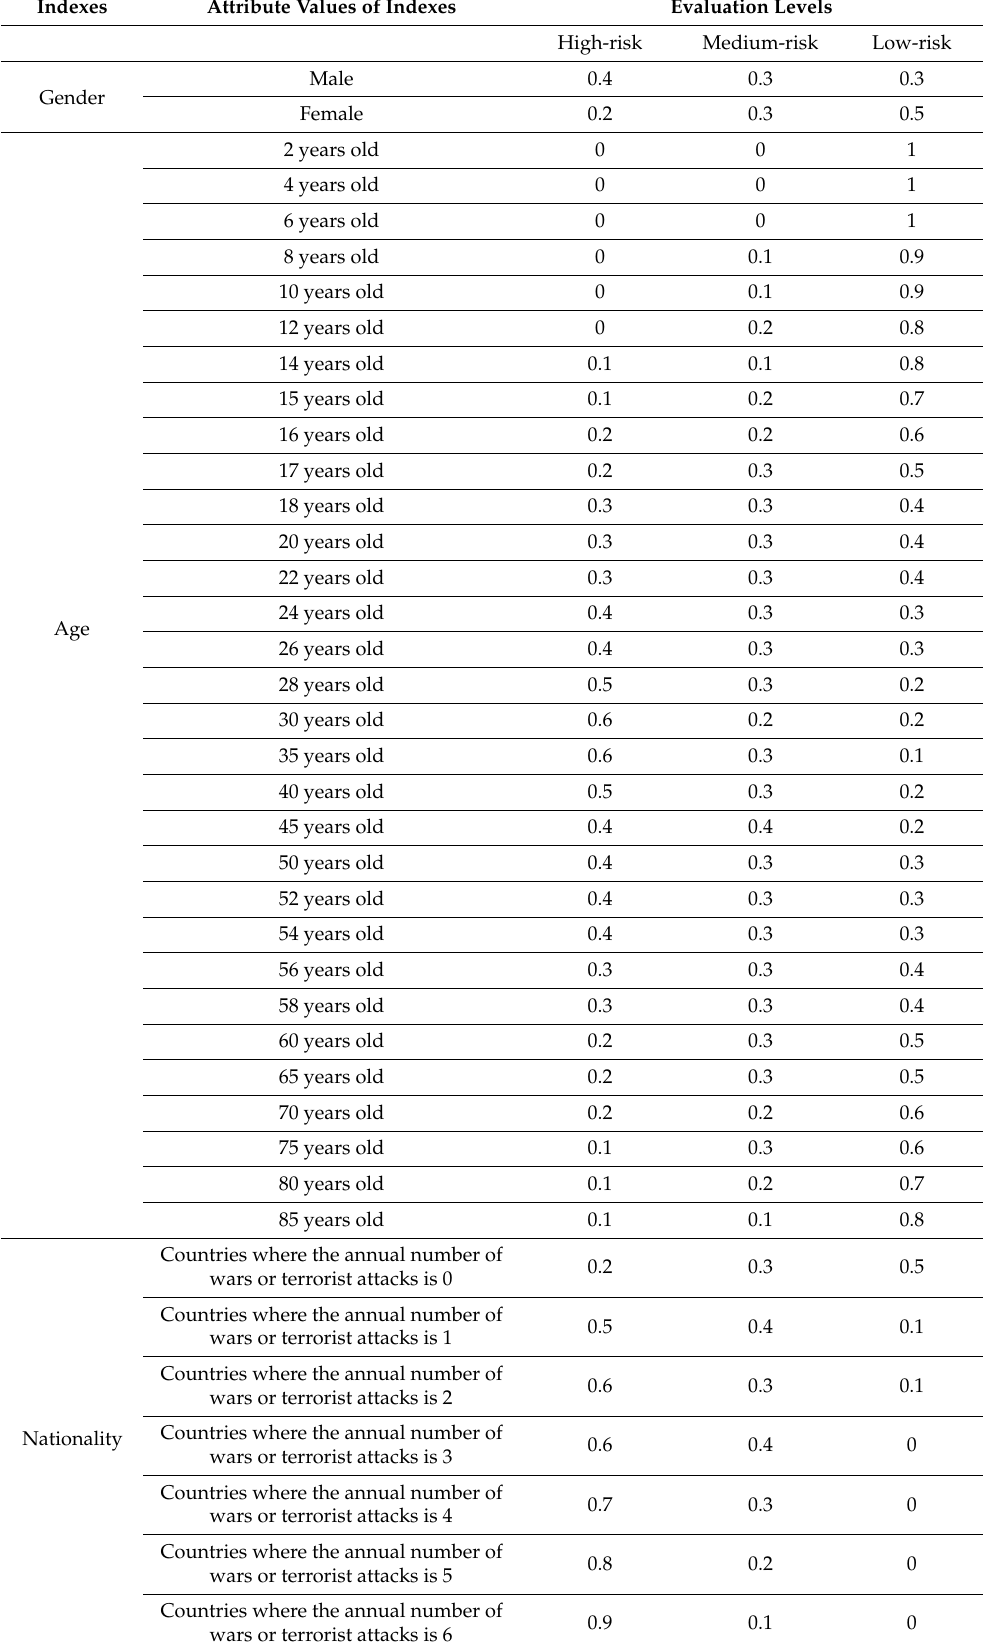
Table A12. Single factor evaluation of basic background